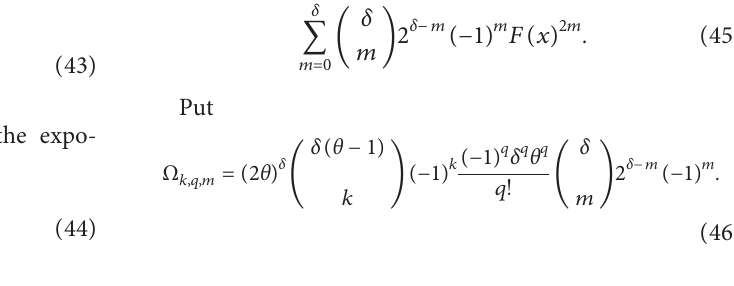
Plot of MSE vs. n